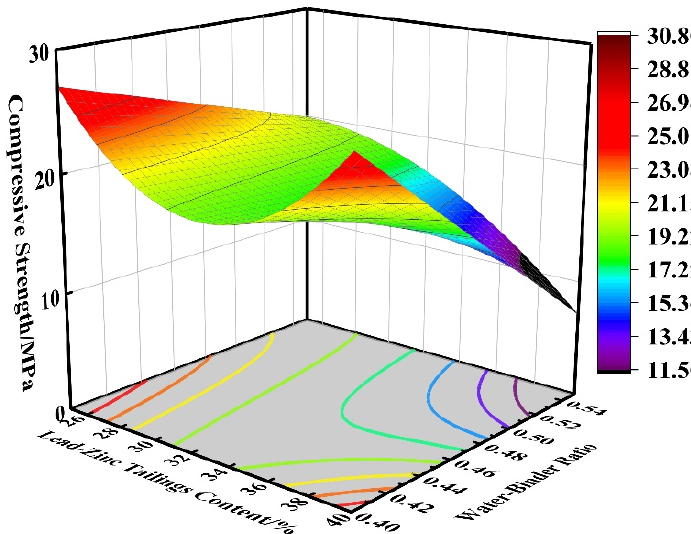
Figure 9. Effect of BC on compressive strength.